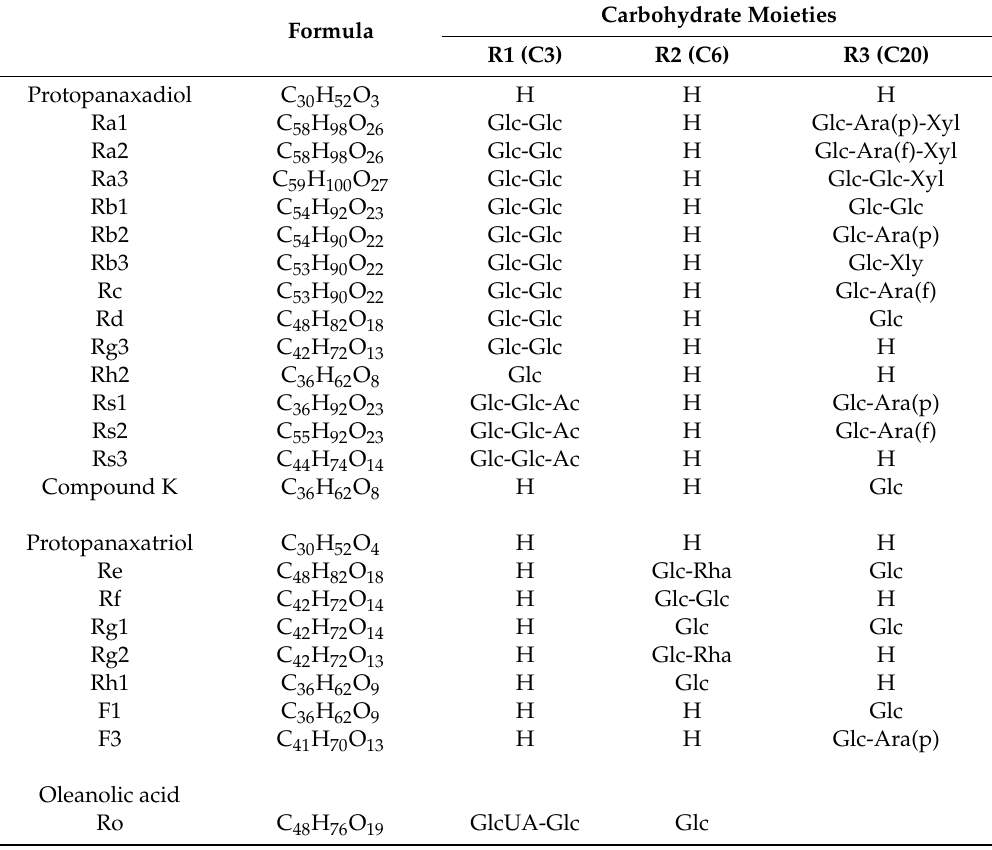
Table 1. Summary of ginseng saponin carbohydrates.